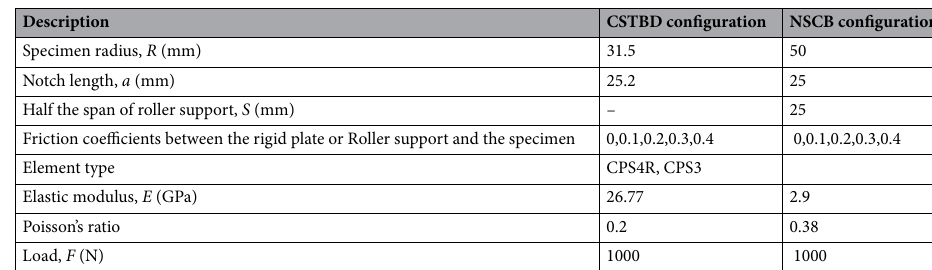
Table 1. Input parameters used in rock models with CSTBD and NSCB configurations.